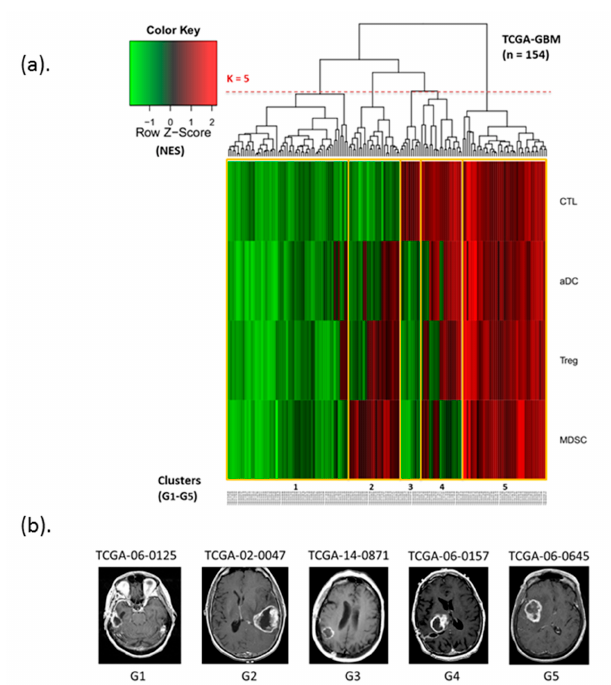
Figure 1. Characterization of glioblastoma (GBM) immunophenotypes by four immune subsets. ( a ) Enrichment levels of immune cell subsets from low to high are represented by a color gradient from green to red. Unsupervised clustering was based on the enrichment profiles of cytotoxic T lymphocytes (CTL), activated dendritic cells (aDC), Treg, and myeloid-derived suppressor cells (MDSC) subsets; patients with GBM could be divided into five subgroups ( K = 5). ( b ) Imaging data (T1 contrast imaging) from each five subgroups were also listed.